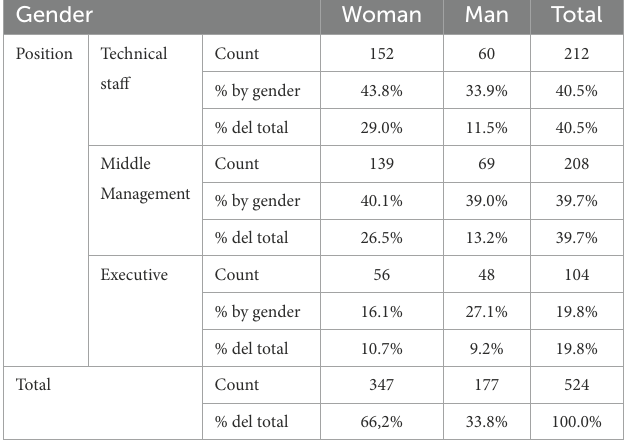
TABLE 2 Research sample by groups of the IV and position in the